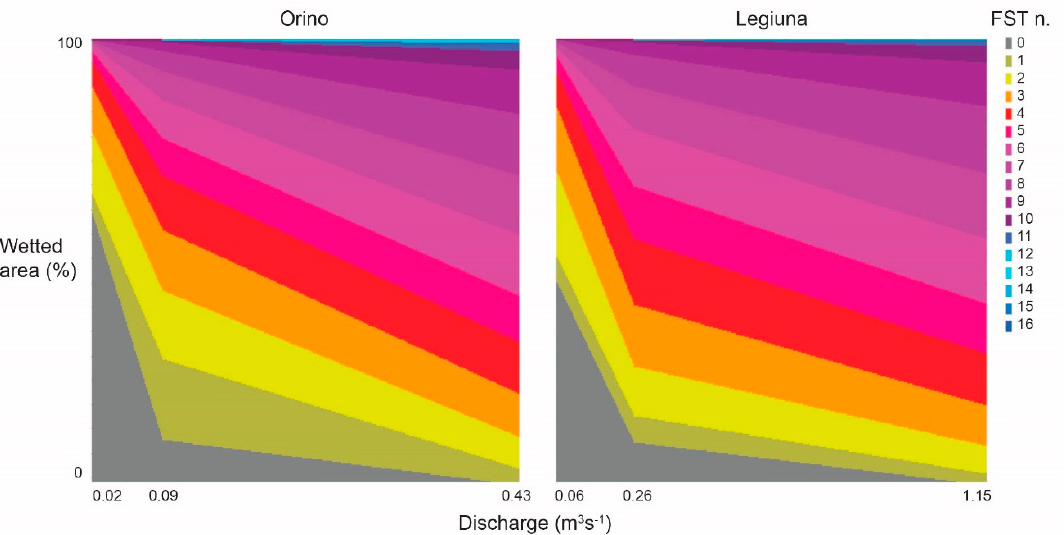
Figure 2. Relative wetted area for FST hemispheres at measured discharges, as modelled by CASiMiR module Benthos. X − axis scale differs between sites.